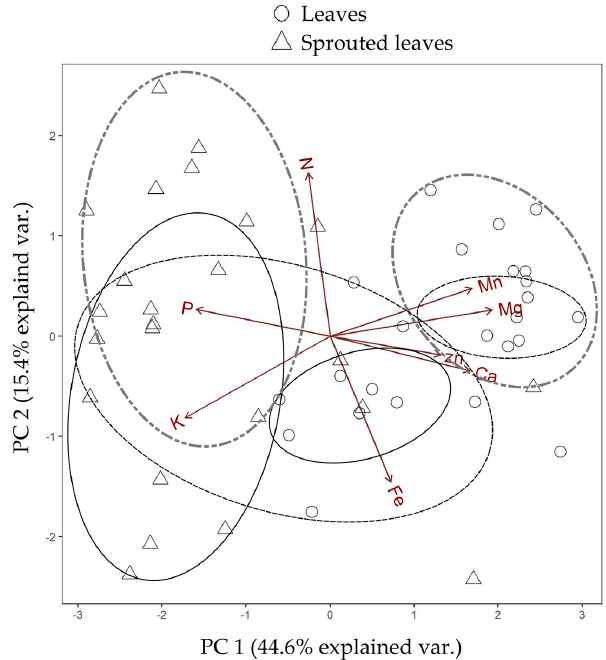
Figure A2. Biplot graph with two first principal components (PC 1 and PC 2) showing the ordering of leaf chemical attribute data for “reference” and “regrowth” material collected by sequential management of the Rosewood mass in the three study areas. Ellipses with dash, dash dot dot and solid line, correspond to areas C10, C12 and C17 respectively.